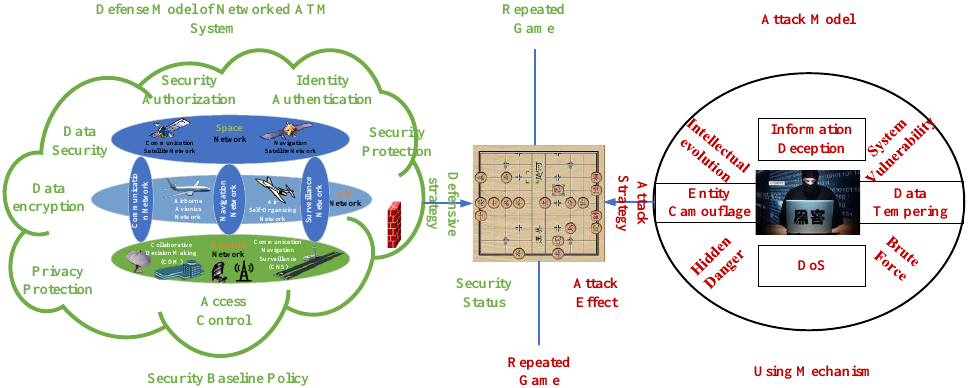
Figure 7. A security situation assessment method for networked ATM system based on Bayesian game theory.